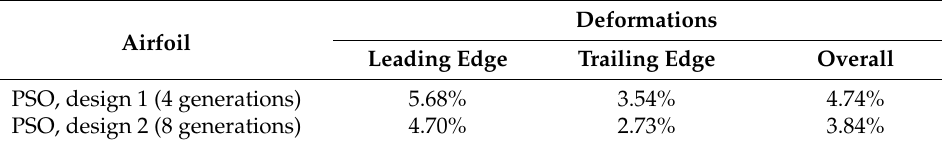
Table 4. Deformations of the LE and TE regions and of the total geometry (length increase with respect to the original geometry) for the optimum design of the aggressive (design 1) and the conservative (design 2) approachusing the PSO algorithm.